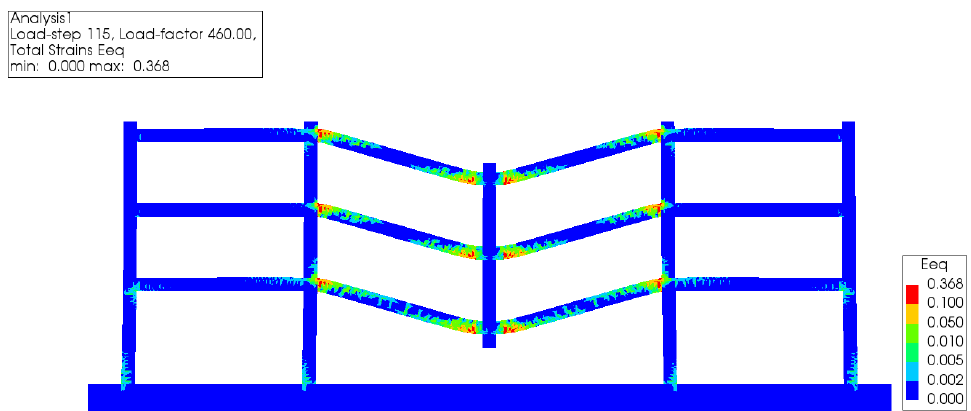
Figure 14. Numerical failure mode of three-storey